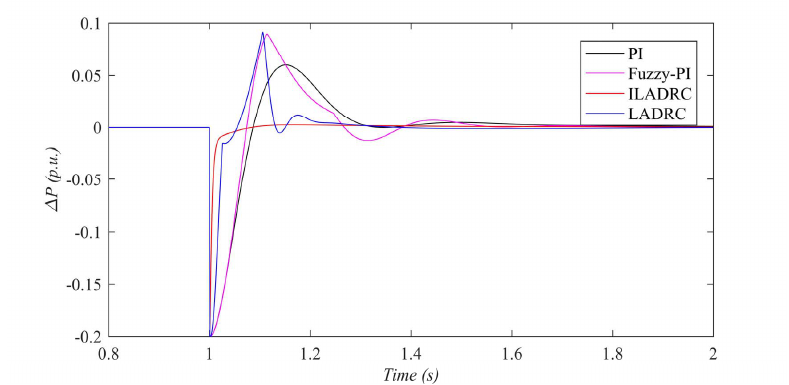
Figure 12. Transient response of system power exchange with +0.2 p.u. change of load